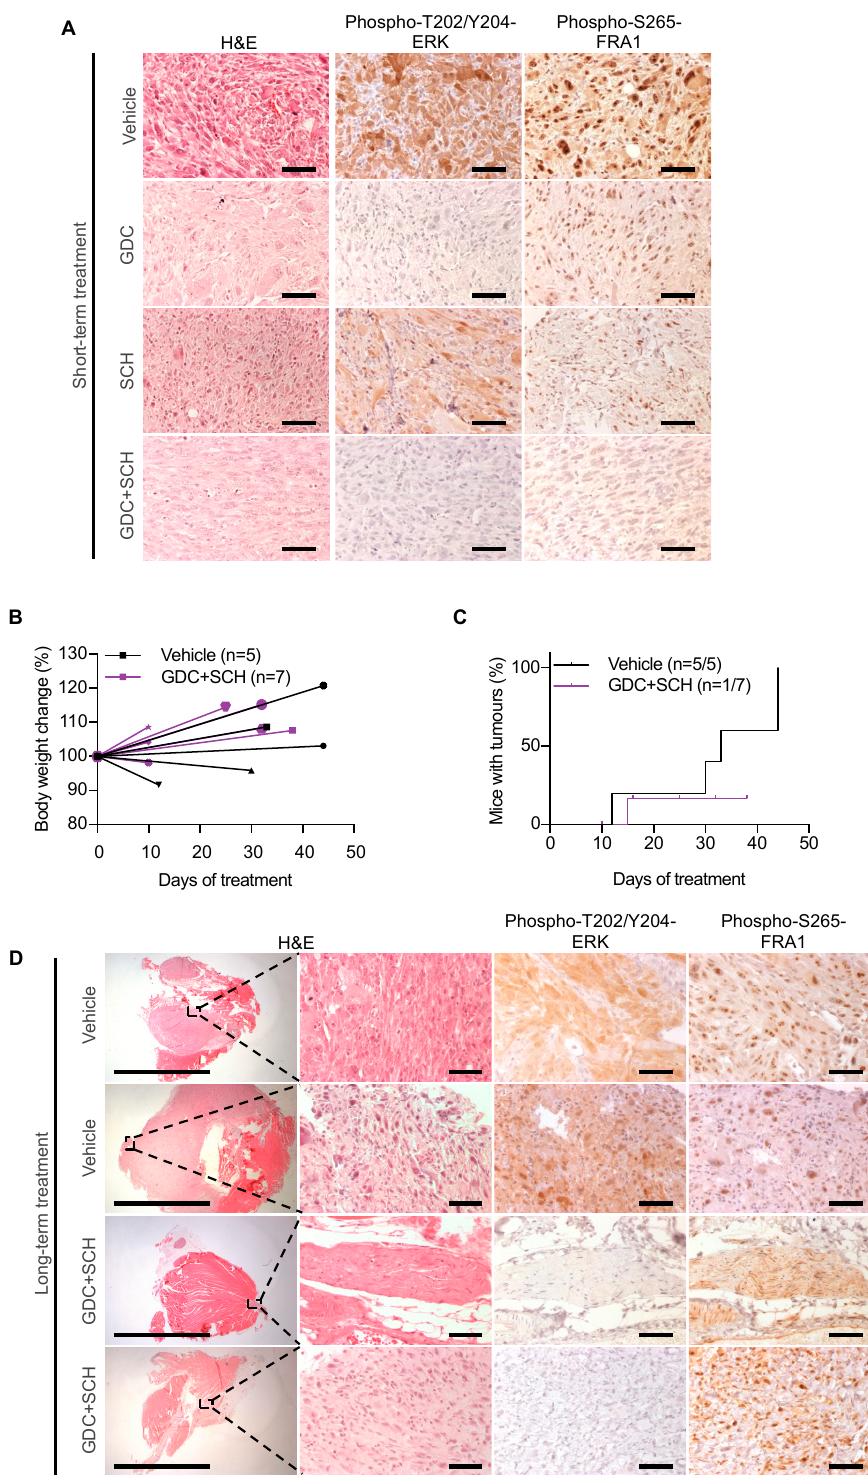
Figure 5. Testing dual MEKi plus ERKi therapy in vivo . ( A ) H&E and immunohistochemical stainings on tumor samples after short-term treatment with vehicle, GDC, SCH or GDC + SCH. Stainings are representative of 2, 2, 3 and 2 independent tumors of each treatment respectively. ( B ) Body weights trend/distribution between start and end of long-term therapy. Each line represents one